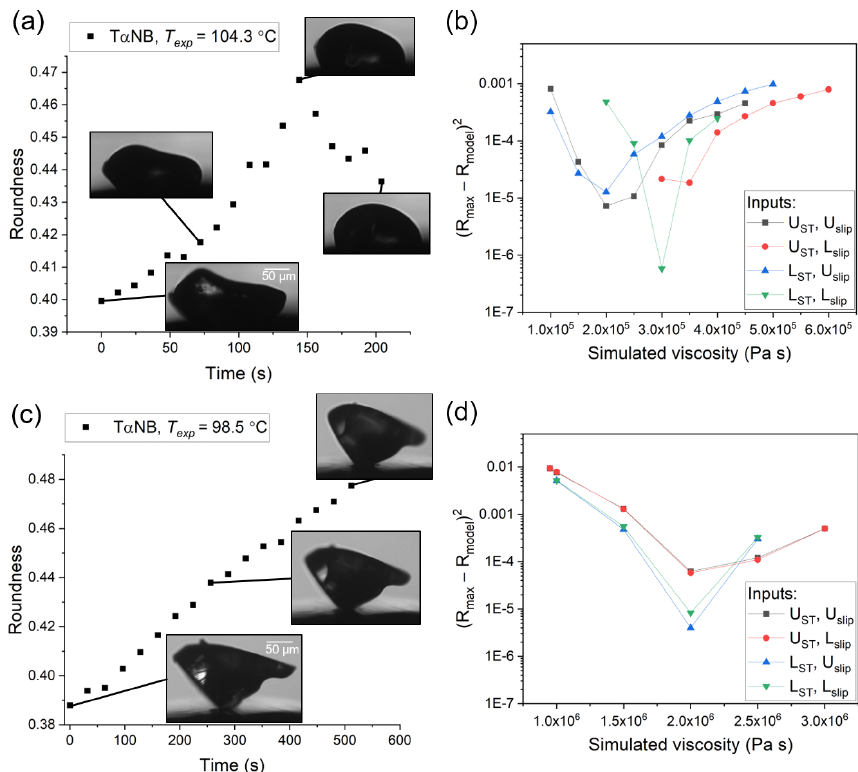
Figure 4. Hot-stage microscopy experiments with T α NB. Roundness as a function of time at (a) 104.3 ◦ C and (c) 98.5 ◦ C. The squared difference between observed and simulated roundness as a function of simulated viscosity for the two sample T α NB experiments, where panel (b) corresponds to panel (a) and panel (d) to panel (c) . The simulation that best reproduces the observation corresponds to the minimum sum of squared difference. The different colors correspond to different input combinations of surface tension and slip length used in the simulations, where U ST , U slip , L ST , and L slip correspond to the upper limit of surface tension, the upper limit of slip length, the lower limit of surface tension, and the lower limit of slip length,